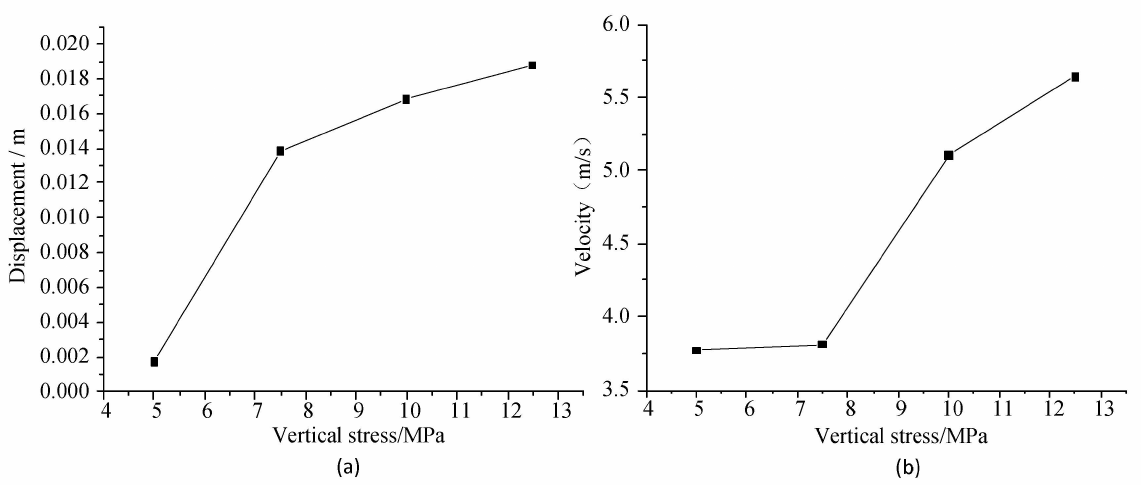
Figure 4. The maximum displacement and velocity statistics of the fracture block of the coal sample under different in situ stresses: ( a ) maximum displacement comparison of fracture coal blocks; ( b ) maximum velocity comparison of fracture coal